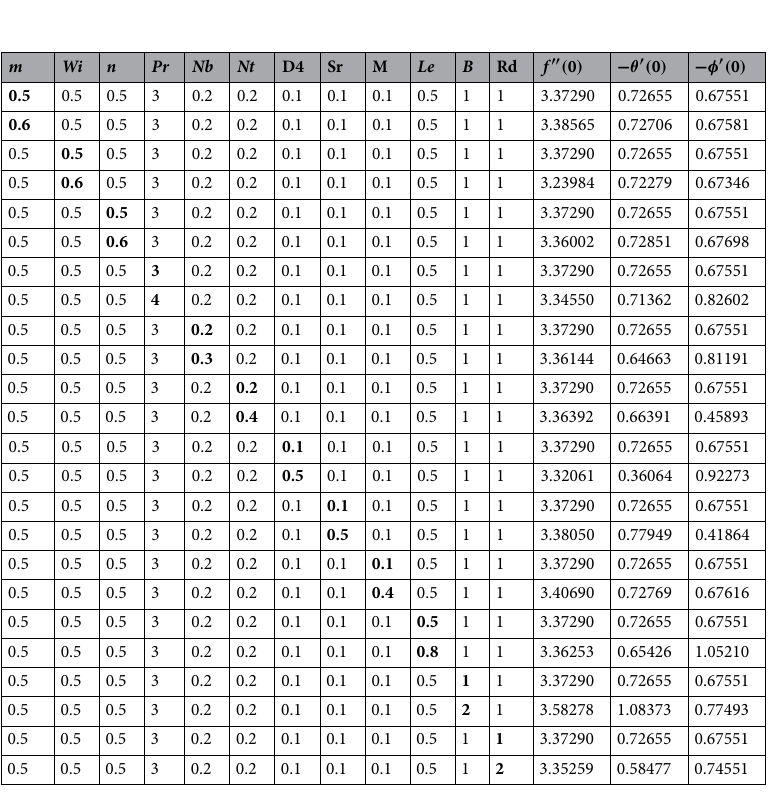
Table 3. Variation of Shearing stress, heat and mass transfer rates. Significant values are in